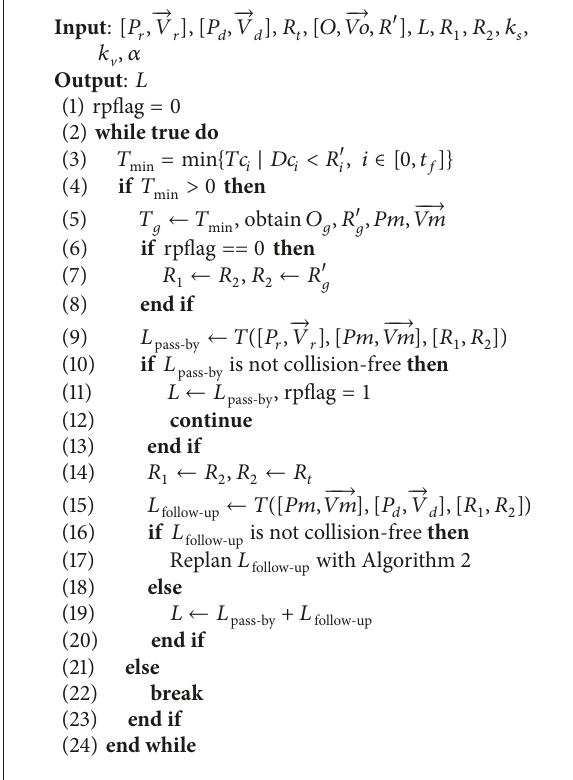
Algorithm 2: Path replanning